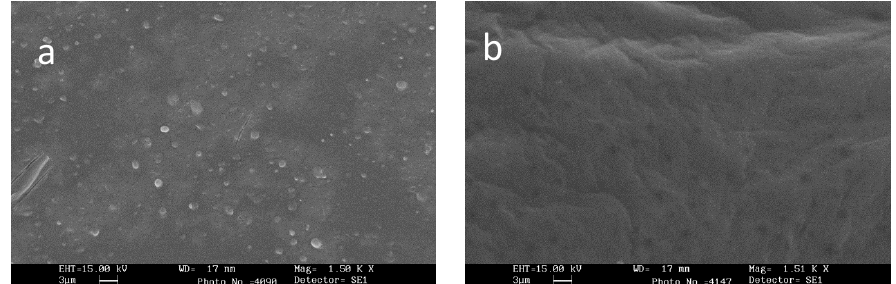
Figure 1. Scanning electron micrographs of films loaded with L. brevis CD2: ( a ) top surface and ( b ) bottom surface.